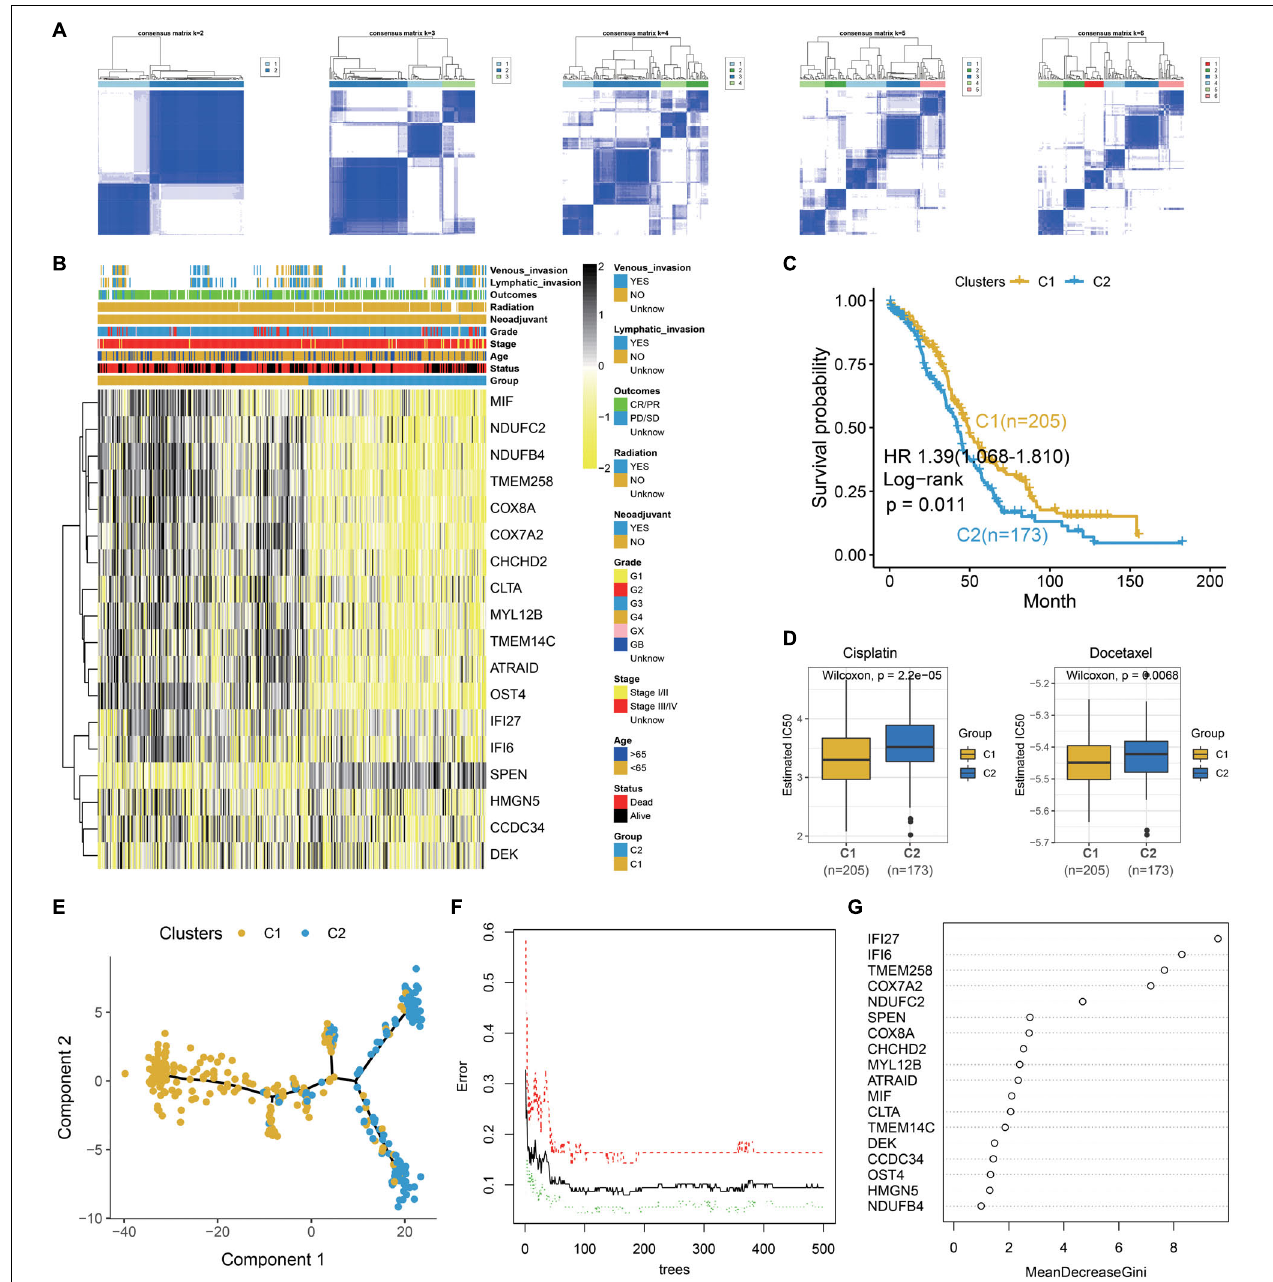
FIGURE 4 | Identification of two clinical treatment subtypes from the TCGA OC dataset. (A) Consensus matrixes of the TCGA OC cohort for k = 2–6. (B) Heatmap of 18 genes in the TCGA OC dataset. (C) Kaplan–Meier plot for two clusters in the TCGA OC dataset. (D) Box plot illustrating that higher IC 50 for cisplatin and docetaxel in C2. (E) Pseudotime graph demonstrating the differentiation process from C1 to C2. (F) Error rate for the data as a function of the classification tree. (G) Importance of 18 genes for the predictors.